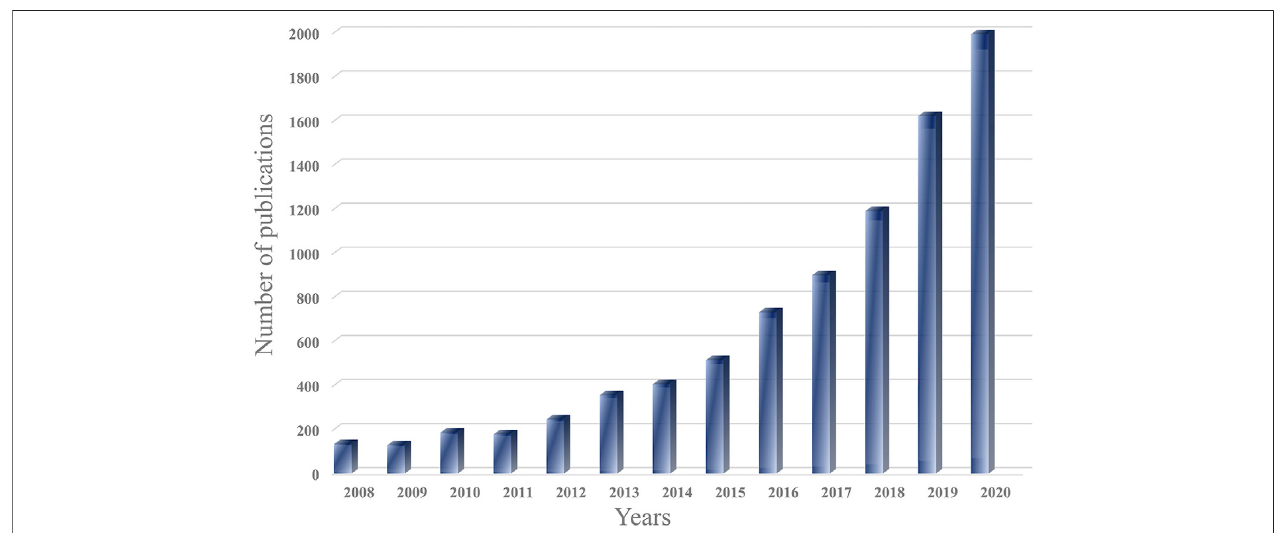
FIGURE 1 | The number of exosomal publications. The graph was generated from Web of Science.